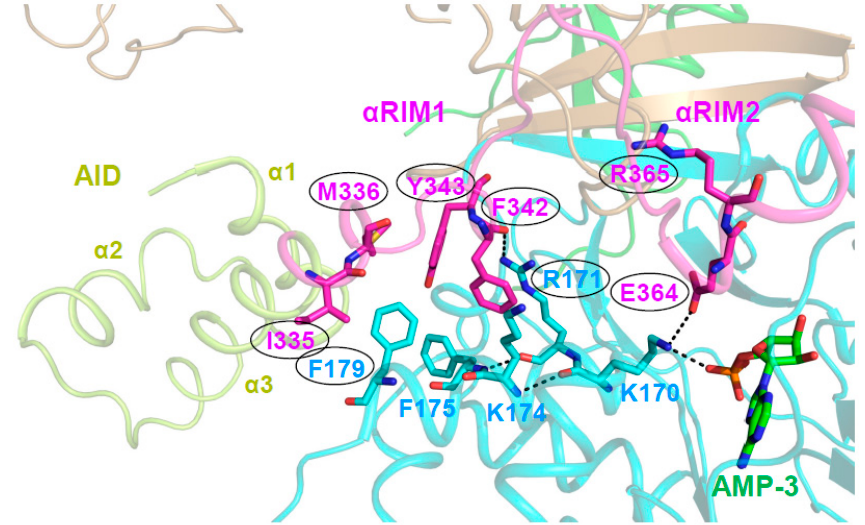
Figure 6. α RIM2/CBS3 and AID- α RIM1/CBS2 interactions are linked. Structure of human AMP-bound AMPK α 1 β 2 γ 1 (4RER) with key residues shown in a stick presentation; the α -linker is shown in magenta, the γ subunit in cyan, and the AID in light green. AMP bound at CBS3 and α RIM2 E364 directly interact with γ 1 K170, which positions the α RIM1-binding residues R171, and indirectly through K174 and F175, F179, thus stabilizing the AID- γ subunit interaction. Consistently, mutations of the α RIM1/ γ subunit (and α RIM2/CBS3) interface residues highlighted by oval outlines (human α 1 : F342D/Y343D, I335D/M336D, E364, R365; γ 1 : R171A, F179D) are constitutively AMP-non-responsive. Dashed lines indicate hydrogen bonds.